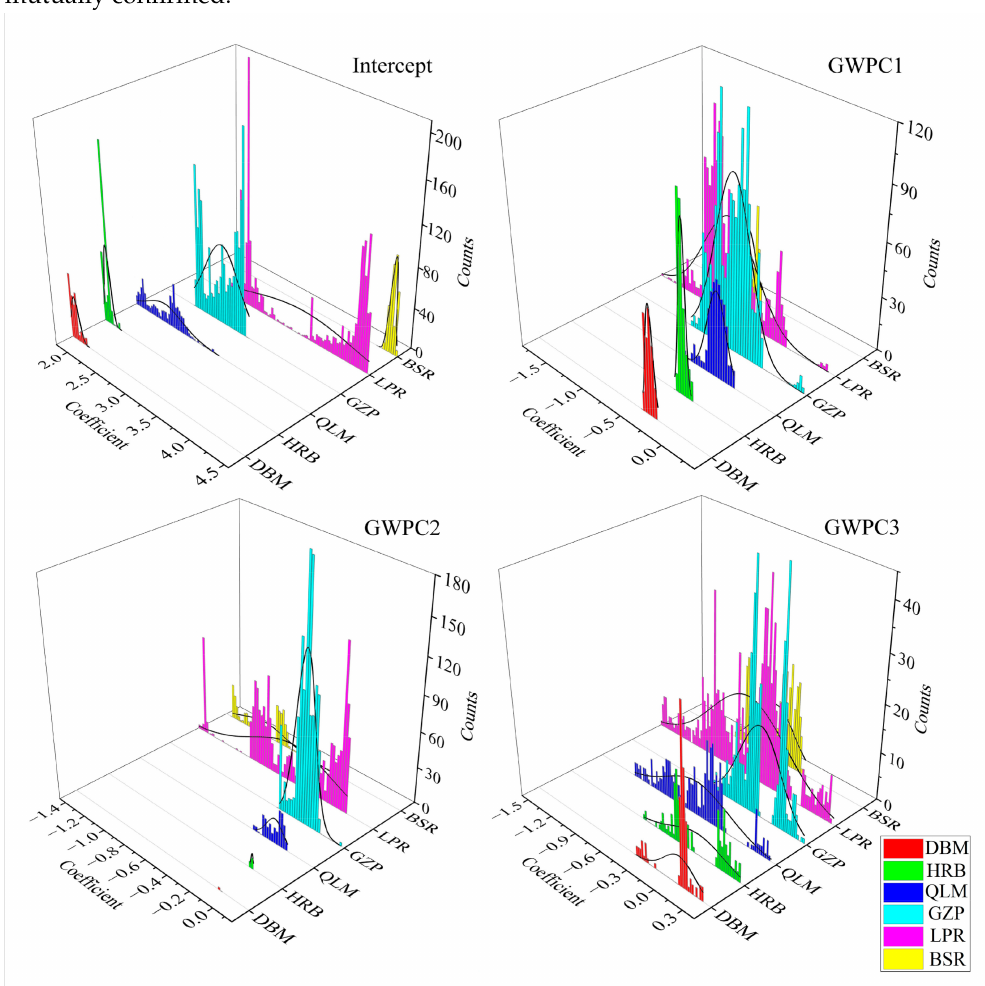
Figure 7. The stacked histogram of MGWR local coefficients (Significance level of